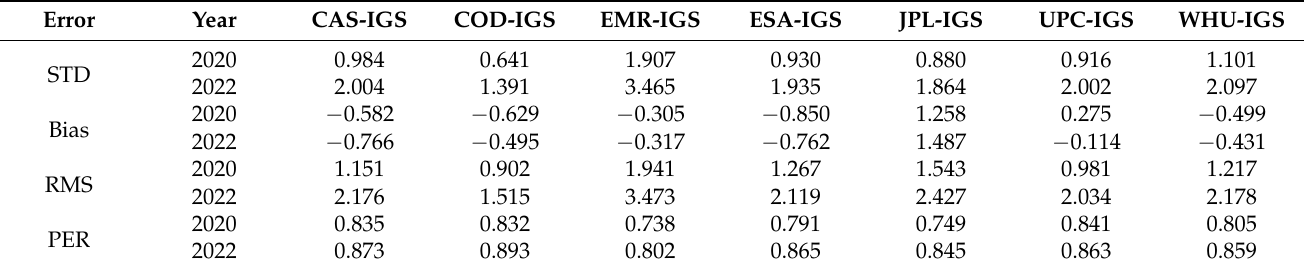
Figure 3. Model deviations of GIMs in 2020 and 2022 compared to the IGS final GIM. Table 2. Annual average precision of ionospheric TEC for GIMs, in the units of